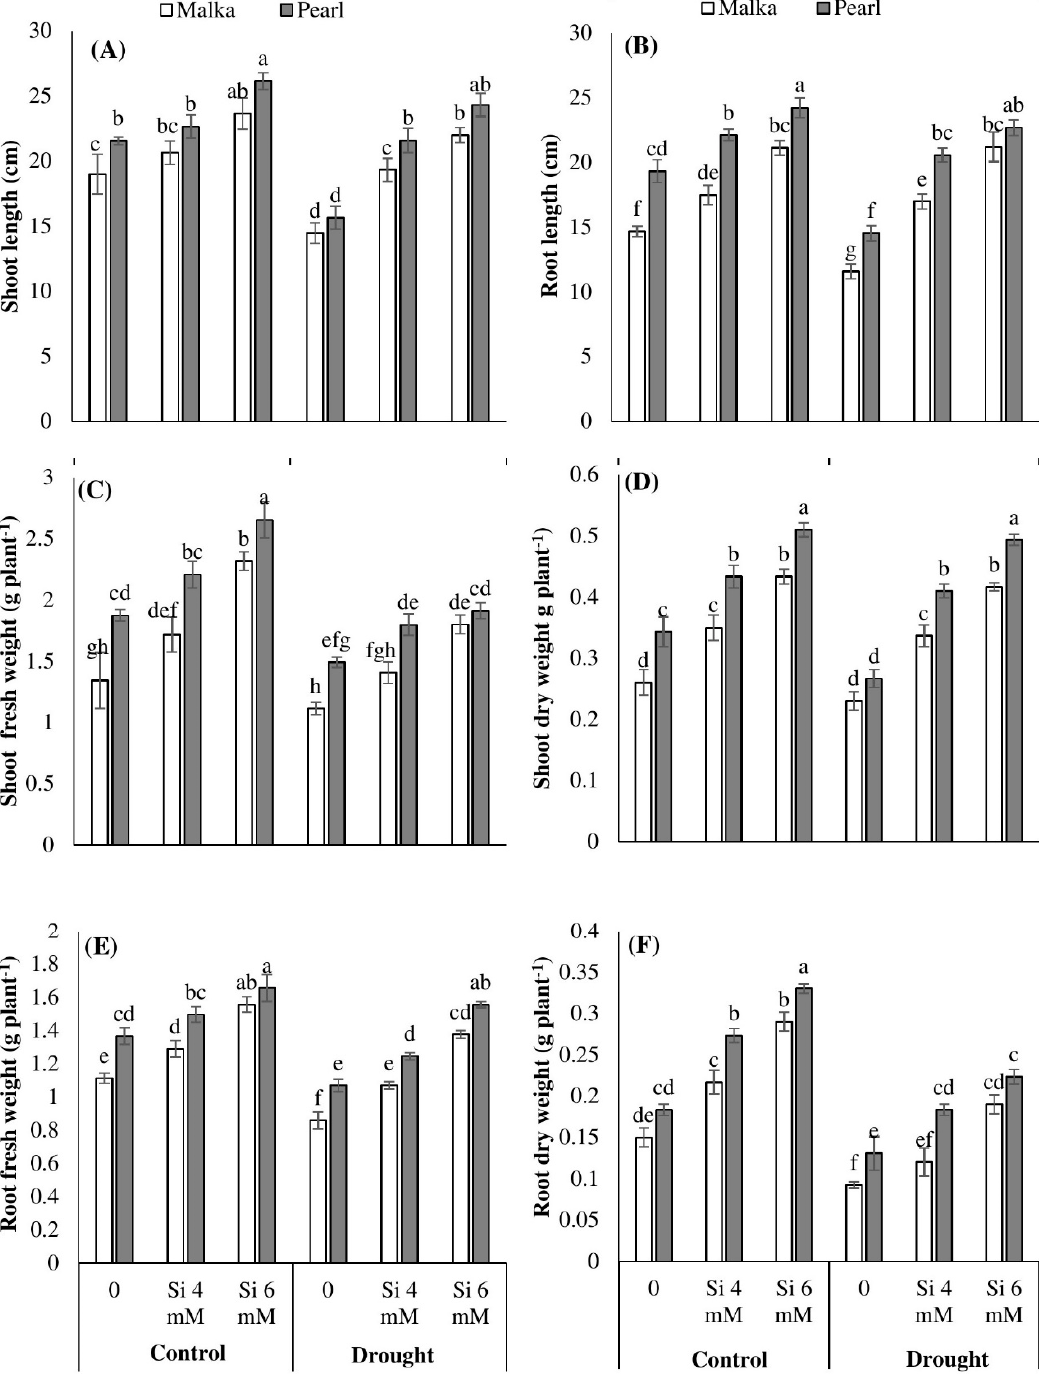
Figure 1. Effect of seed priming with silicon on ( A ) shoot length, ( B ) root length, ( C ) shoot fresh weight, ( D ) shoot dry weight, ( E ) root fresh weight, and ( F ) root dry weight of two maize cultivars under drought stress. Mean with same letter(s) do not differ significantly at p < 0.05. Error bars above the means indicate standard error ( n = 3).